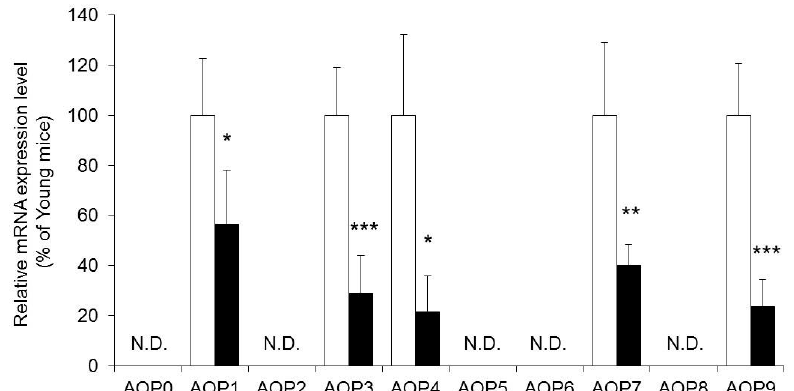
Figure 2. The mRNA expression level of aquaporins (AQPs) in the skin. The whole skin, containing epidermis and dermis, was harvested from young (white) and aged mice (black). The mRNA expression level of AQPs in the skin were measured using real-time RT-PCR, and normalized to β -actin. Mean levels of AQP mRNA expression of young mice are indicated as 100%. The data represent the means ± SDs for five mice. Student’s t -test: * p < 0.05, ** p < 0.01 and *** p < 0.001 vs. Young mice. N.D.: Not detect.